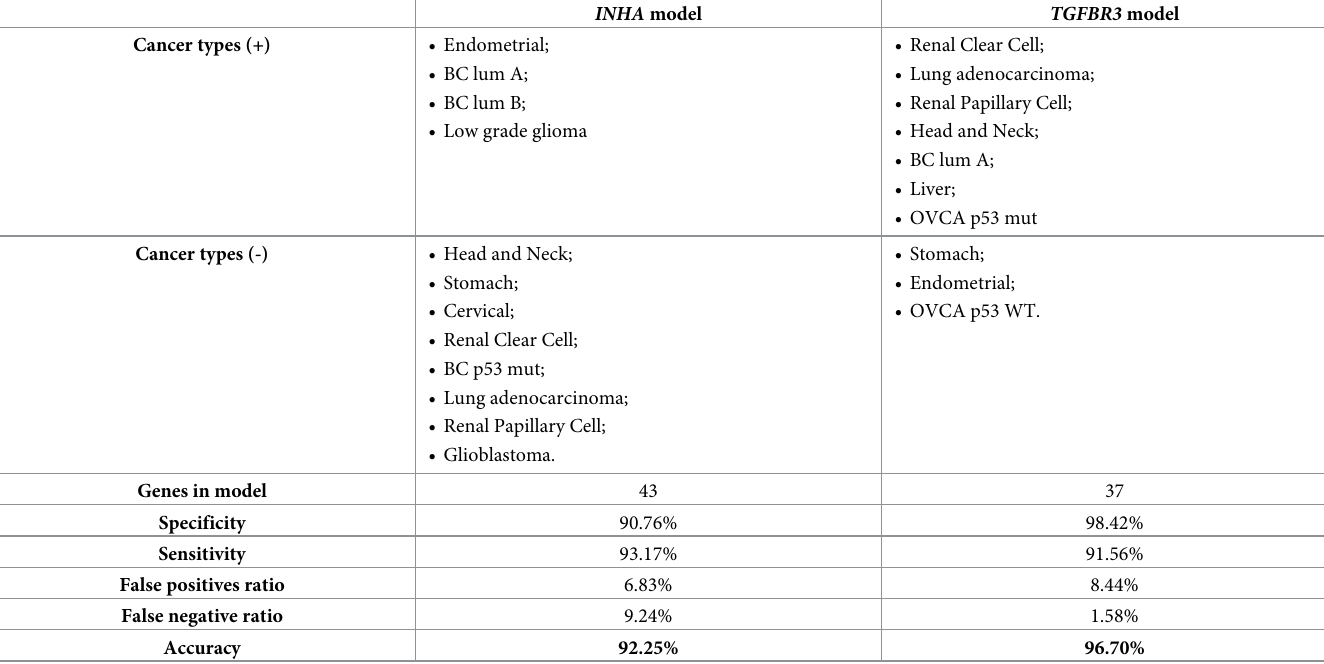
Table 2. Prognostic performance of each delineated probit